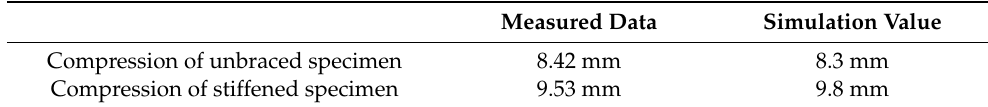
Table 4. Comparison of the measured and simulated values.